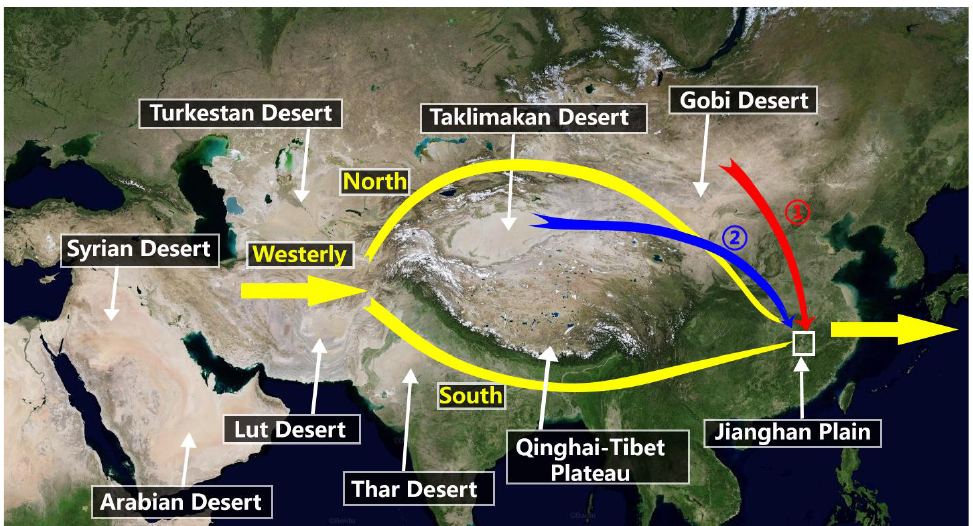
Figure 1. Geographical location of the Jianghan Plain, surrounding dust sources, and the main dust transport path to the Jianghan Plain ( ① , ② ). The westerly is divided into the southern and northern branches over the Qinghai-Tibet Plateau and converges at approximately 30°N after crossing the plateau (yellow arrow). The topographic map comes from ArcGIS (https://www.arcgis.com/index. html, accessed on 22 July